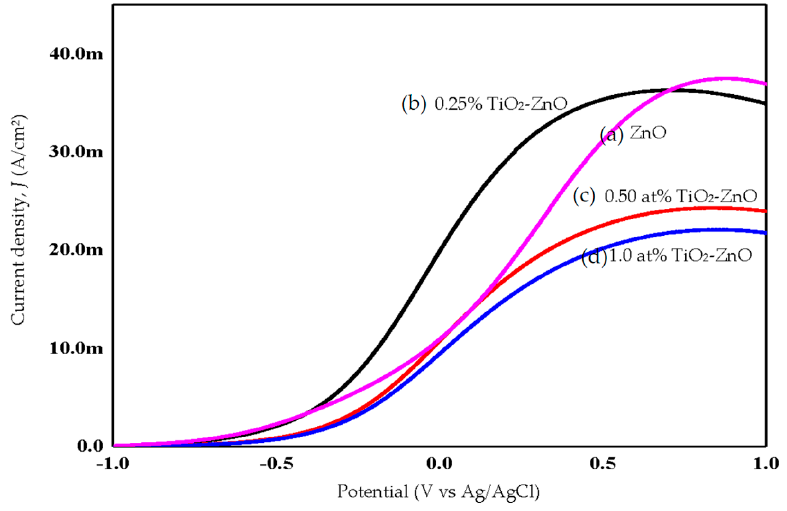
Figure 10. Photocurrent response of ( a ) ZnO; ( b ) 0.25% TiO 2 -ZnO; ( c ) 0.50 at % TiO 2 -ZnO; and ( d ) 1.0 at % TiO 2 -ZnO under UV illumination.